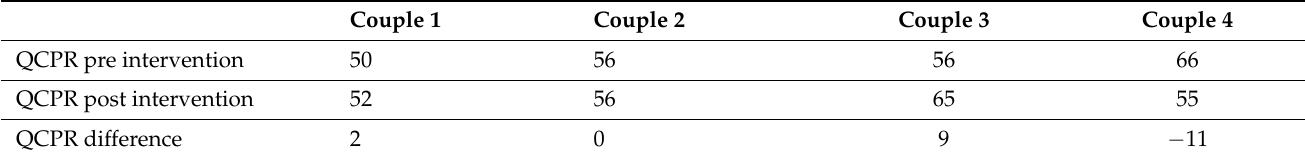
Table 5. QCPR results for individually recruited